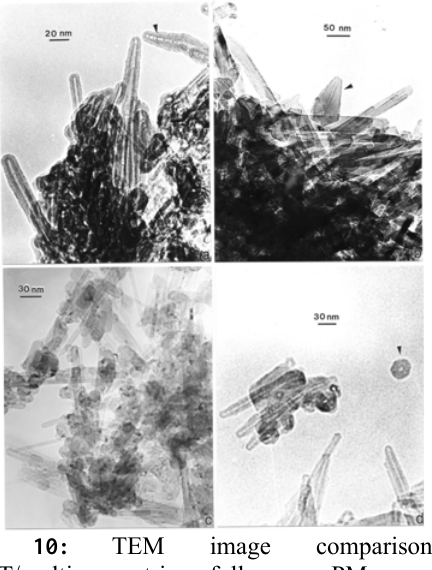
10: TEM image comparison for MWCNT/multiconcentric fullerene PM aggregates collected by thermal precipitation. (a) Pure methane air flame product. (b) Natural gas (96% methane)-air flame product (c) and (d) show propane-air flame products.